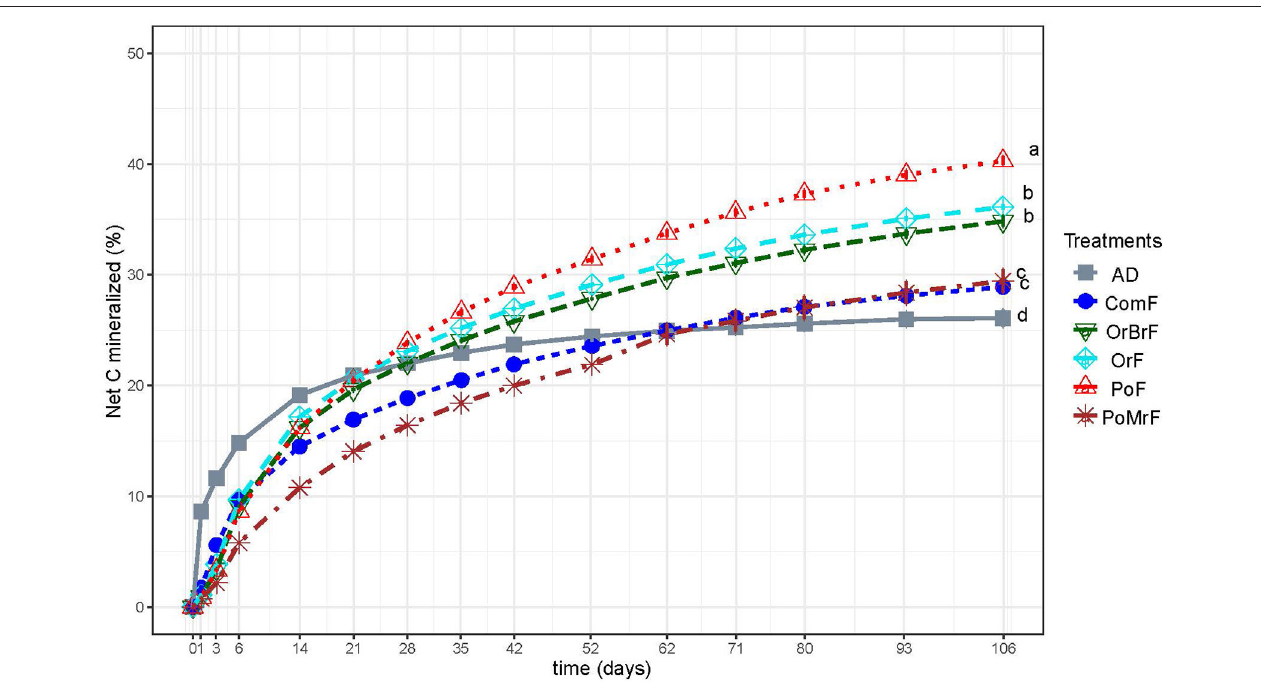
FIGURE 1 | The dynamics of cumulative net CO 2 -C mineralized from bio-based fertilizers are expressed as a percentage of total organic C added in each treatment. Different letters show significant statistical differences as assessed at the end of the incubation ( p < 0.05).